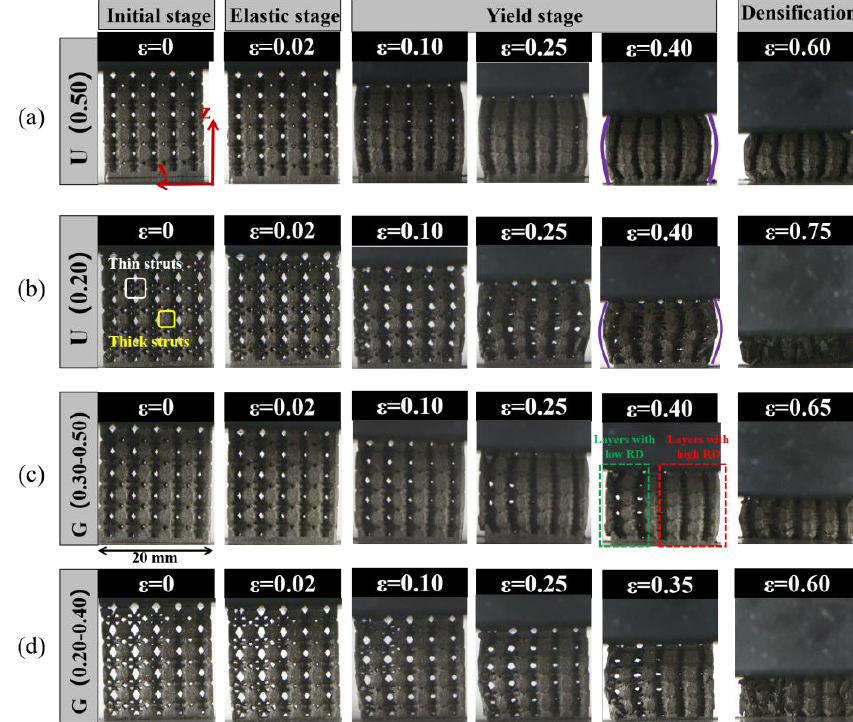
Figure 9. Compressive deformation behaviors images of different lattice structures under increasing strain: ( a ) U(0.50), ( b ) U(0.20), ( c ) G(0.30–0.50), ( d ) G(0.20–0.40).